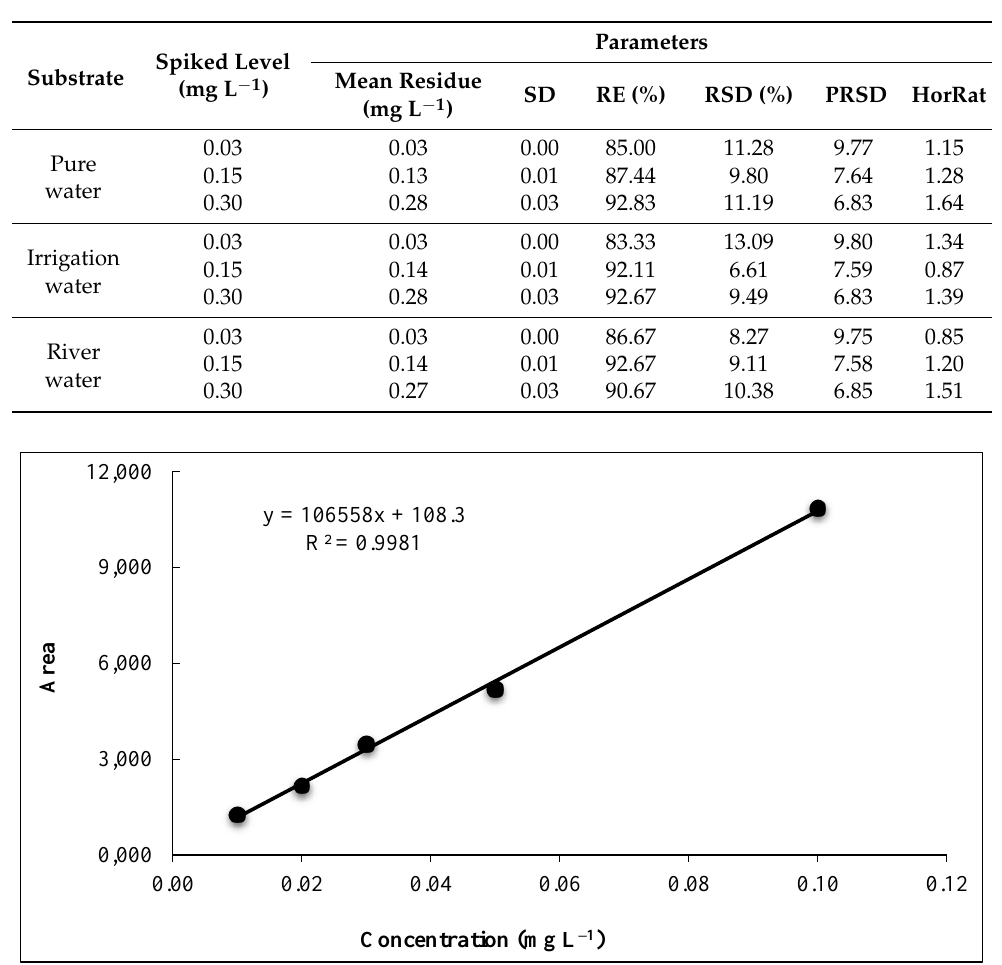
Table 3. Results of method validation of flucetosulfuron.